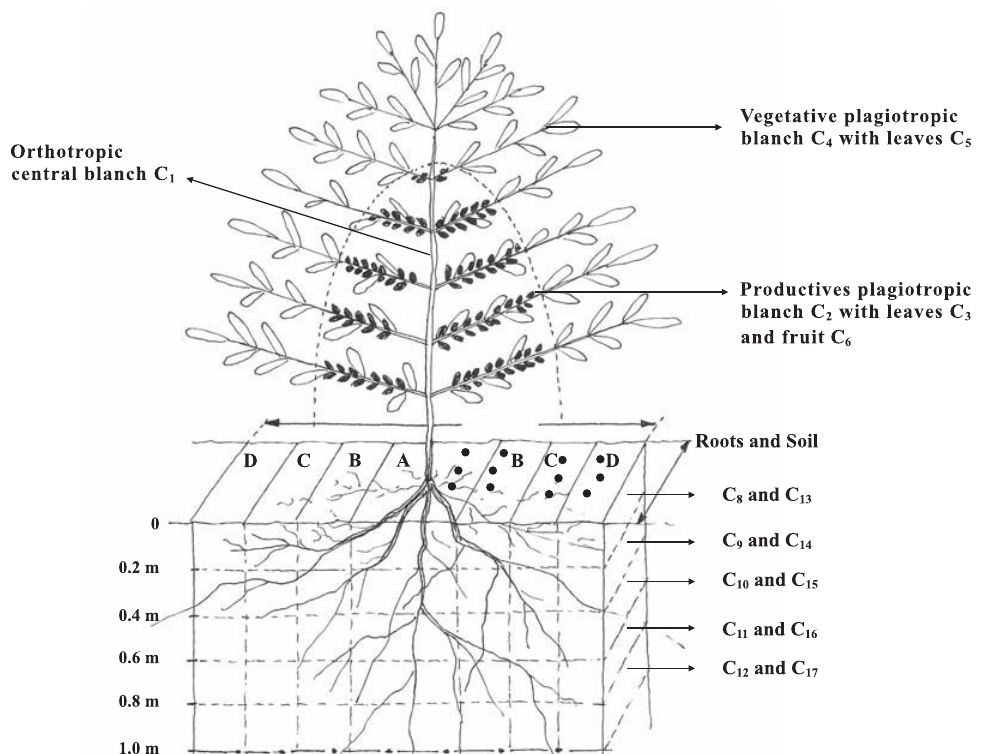
Figure 2. Schematic view of shoot, root and soil compartments (C). Points ( ) in areas A, B, C and D indicate positions of auger